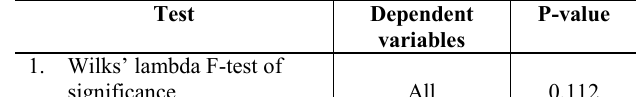
Table 4: The results of the test to investigate relationships between person culture and strategy